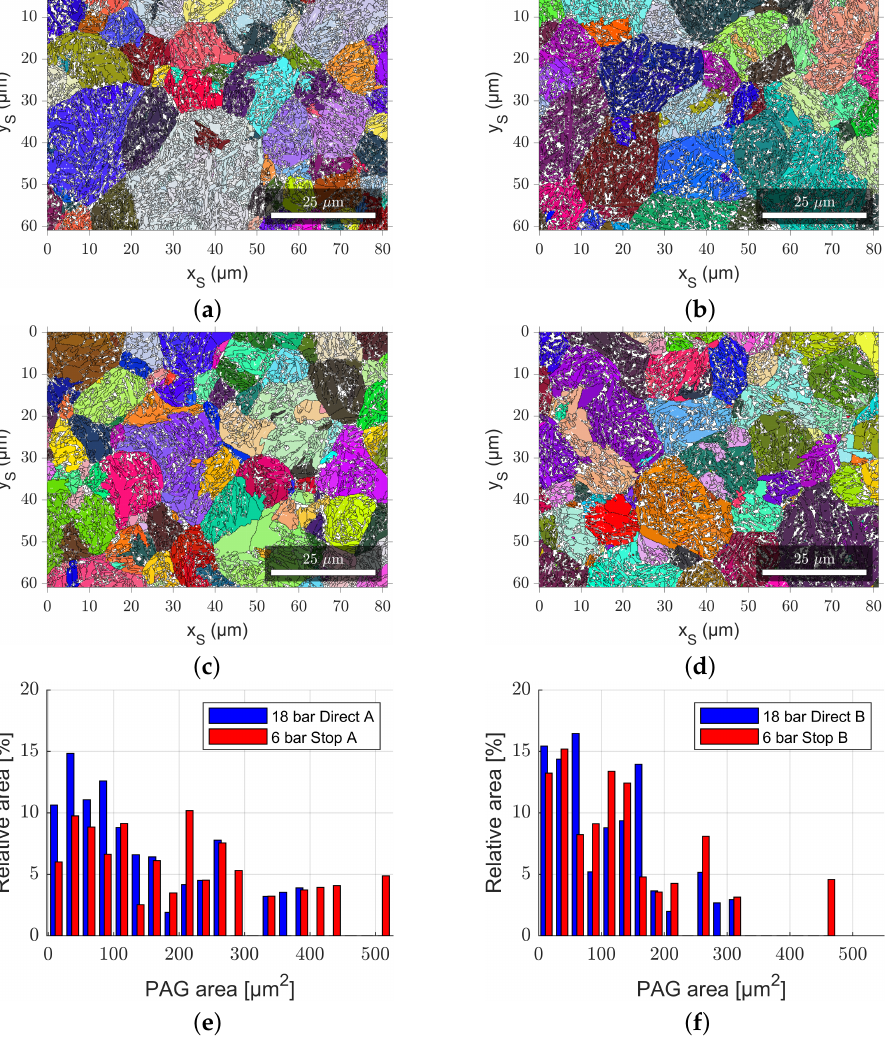
Figure A3. Reconstructed austenite orientation map together with martensite unit boundaries for 20MnCr5 (A) and 17NiCrMo6-4 (B) ( a , c ) 18 bar Direct and ( b , d ) 6 bar Stop, distribution of relative PAG area for 18 bar Direct (blue) and 6 bar Stop (red) for ( e ) 20MnCr5 (A) and ( f ) 17NiCrMo6-4